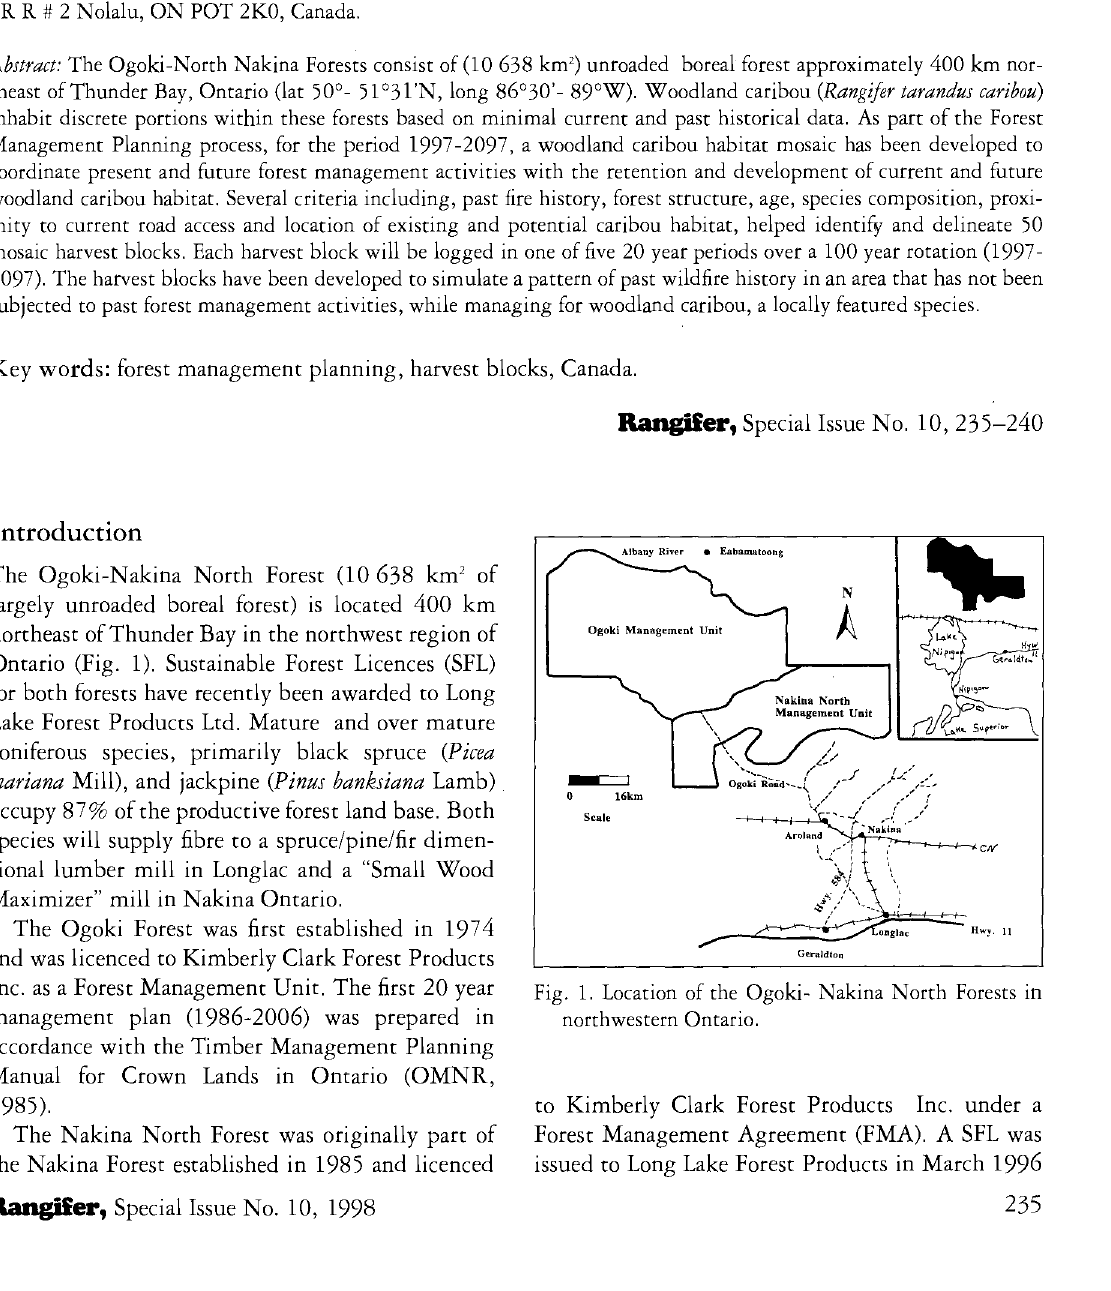
Fig. 1. Location of the Ogoki- Nakina North Forests in northwestern